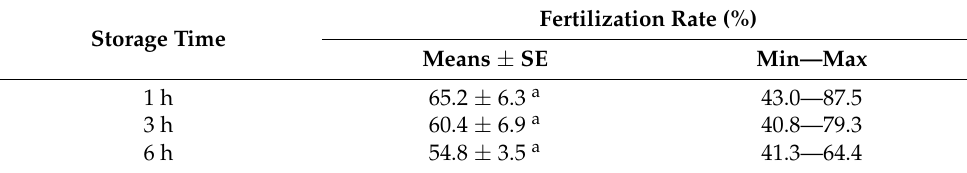
Table 1. Fertilization rate recorded in frozen semen after different storage time intervals. Storage